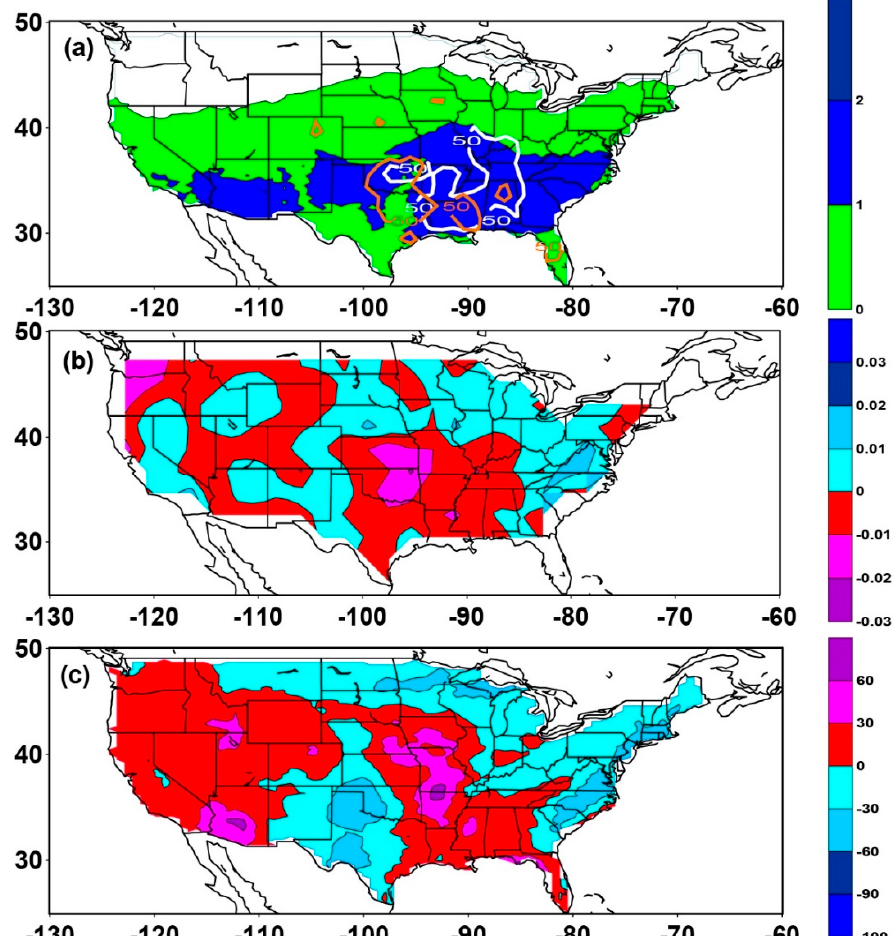
Figure 12. Composite differences (shaded) between high and low event years of ( a ) the 500-1000 hPa wind speed shear (m s − 1 ), ( b ) 850-hPa omega (Pa s − 1 ), and ( c ) convective available potential energy (CAPE) (J Kg − 1 ). Tornado Alley is defined as the core area of (E)F1-(E)F5 tornado counts of 50 or more per 1° × 1° grid box over a 30-year period with orange color contours (in the cold period) and white color contours (in the warm period) in ( a ).